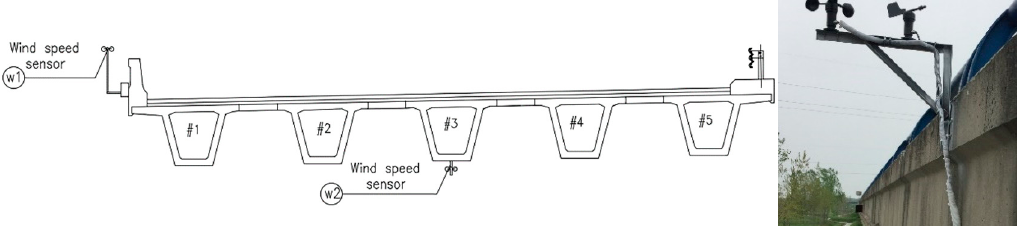
Figure 3. Anemometers for wind speed monitoring positions.